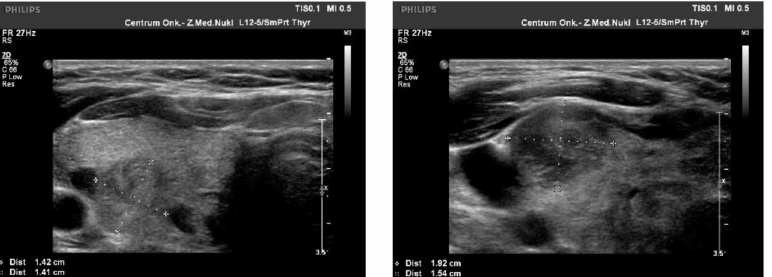
Figure 3. US image of BRAF V600E negative PTCs: solid structure (2 points), isoechogenic or slightly hypoechoic (1–2 point), taller-than-wide orientation (3 points), blurred margins (2 points), absence of calcifications (0 points)—8–9 points = TIRADS